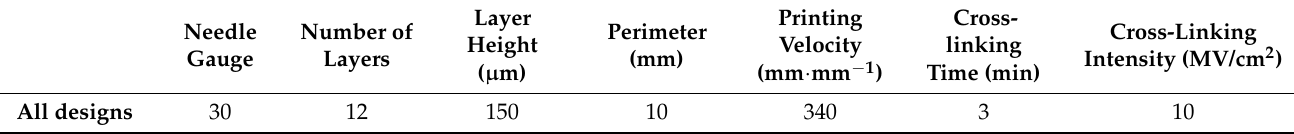
Table 2. 3D printing parameters used to produce all